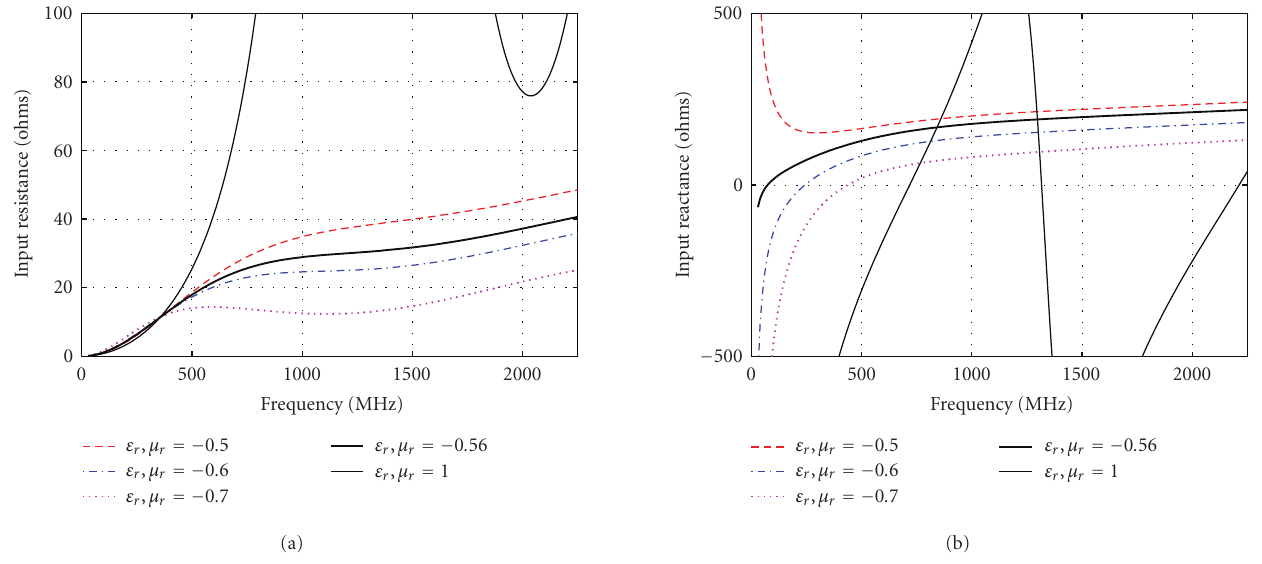
Figure 9: Resonance at lower frequencies: (a) input resistance and (b) reactance. Other parameters: L = 200mm, a = 0 . 3175 mm, b = 1 . 8542 mm, r = 0 . 3175, mm N = 10.